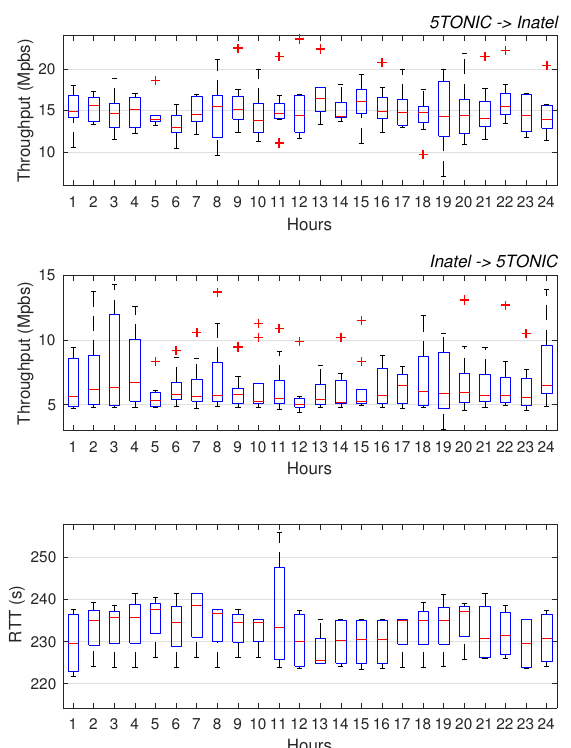
Figure 8. Transoceanic network path performance between 5TONIC and